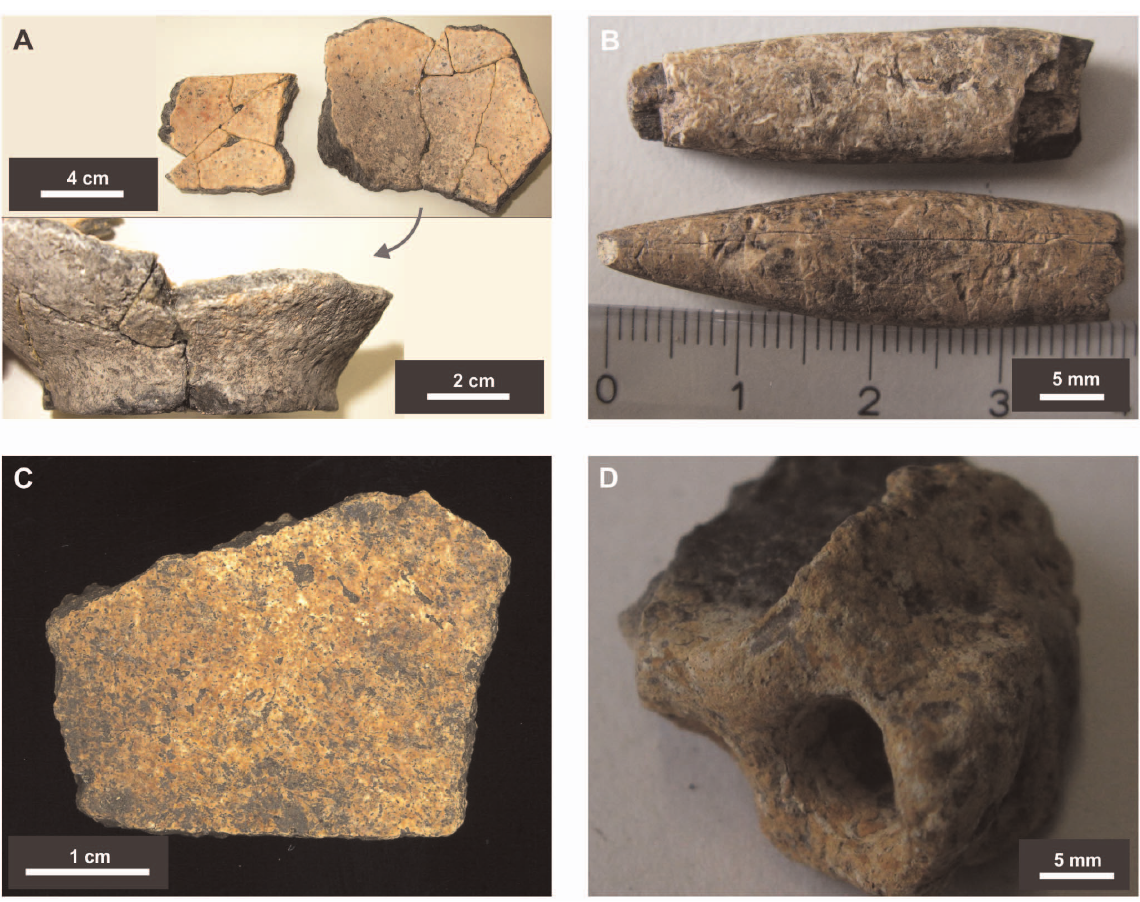
Figure 5. Material retrieved from the uppermost 30 cm of SM1. Unit I, corresponding to the late-Holocene occupation. A) Fragmented pottery; b) Bone tools; c) Fragment of human skull; d) Biogenic burnt earth, probably a wasp chamber.